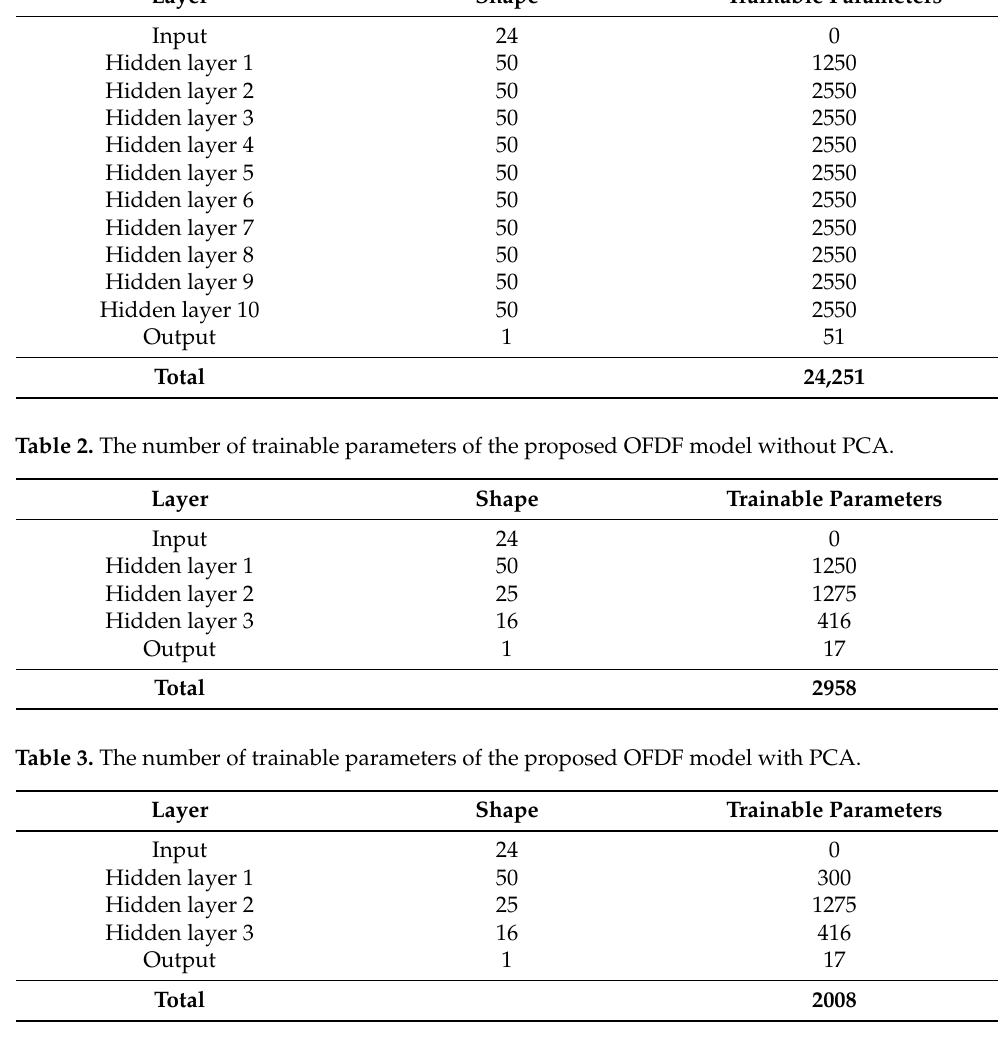
Table 1. The number of trainable parameters of the existing OFDF model [11]. Layer Shape Trainable Parameters